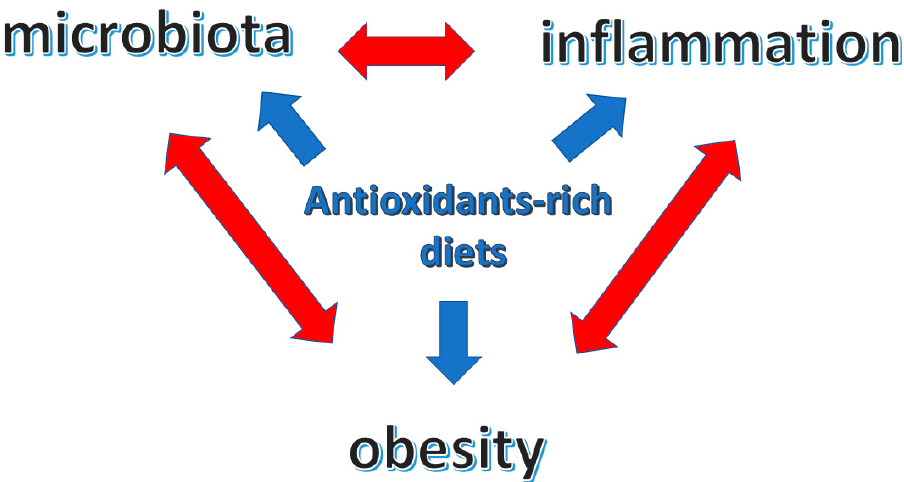
Figure 1. Central role of antioxidants-rich diets in the interplay between microbiota, inflammation and obesity.